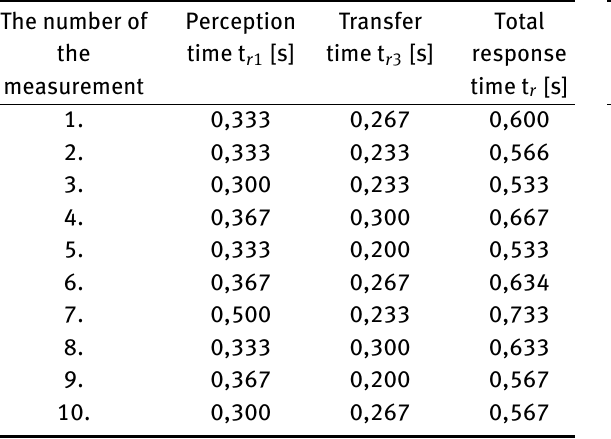
Table 10: Summary of the results of driver E. The number of